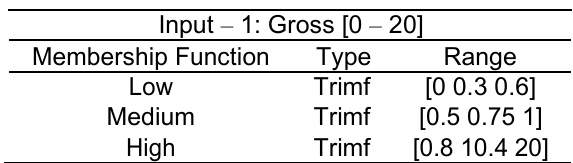
Table 1. Membership functions and ranges for Gross